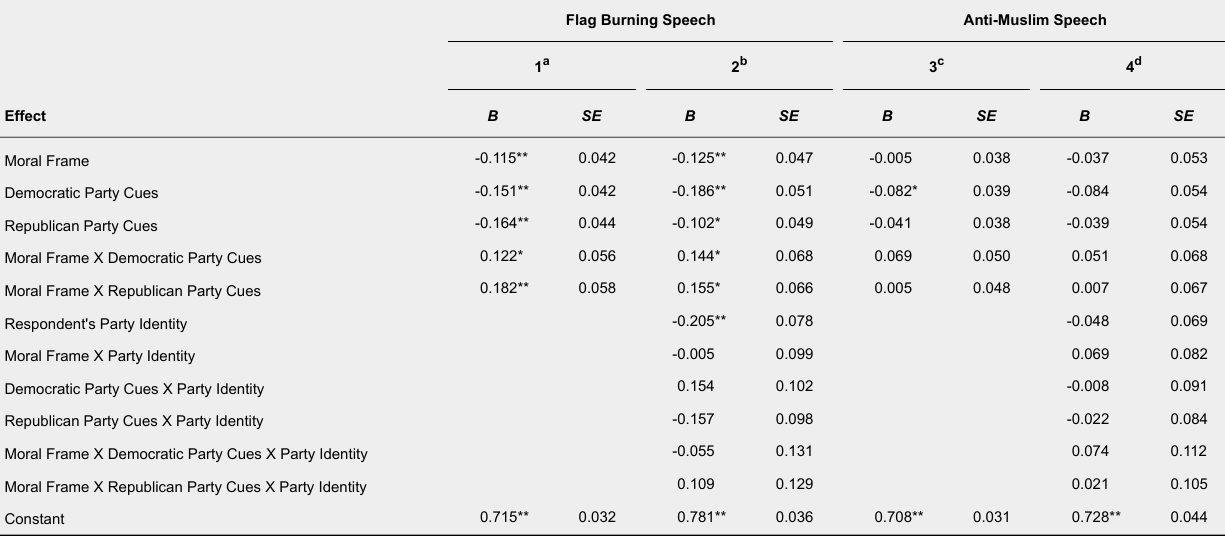
Experimental Treatment Effects for Flag Burning and Anti-Muslim Speech (Study